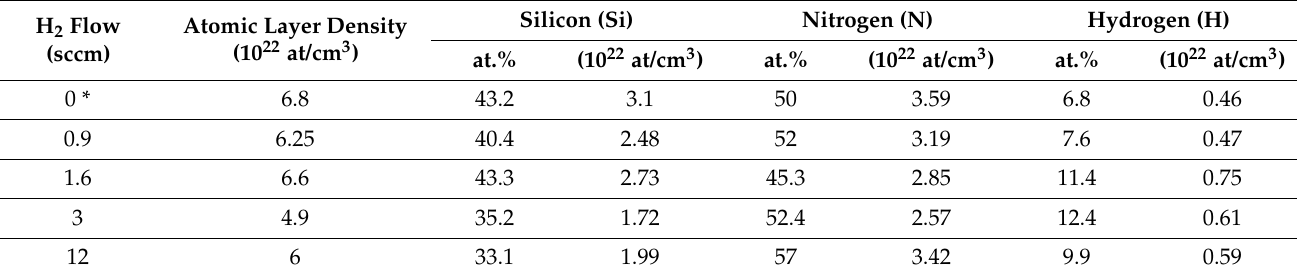
Table 3. Atomic layer densities and concentrations (at.%) and atomic densities (at/cm 3 ) for the Si, N, and H components of a-SiN x :H layers as evaluated from RBS/ERDA measurements using layer thicknesses (in nm) obtained from TEM analysis. * fully closed